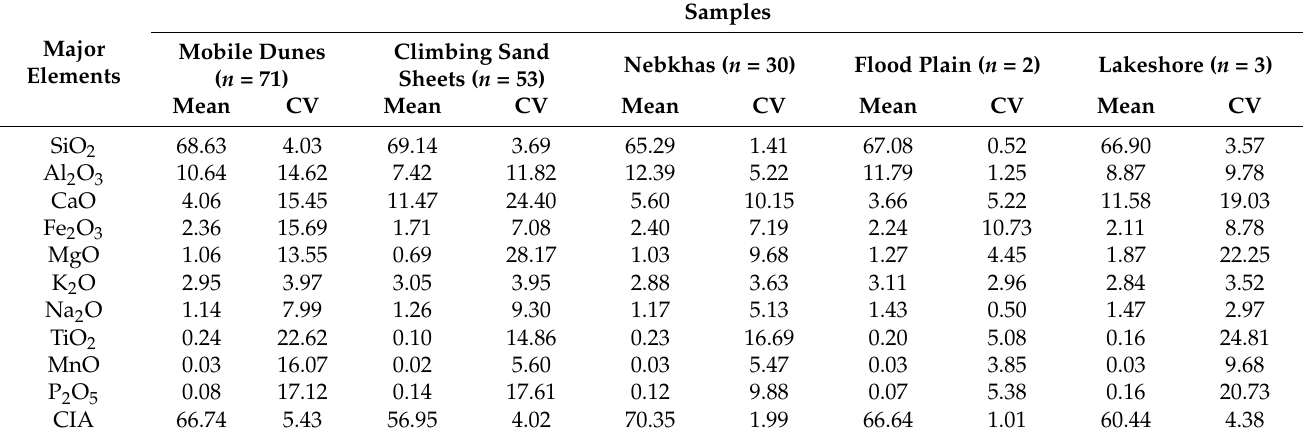
Table 1. Average content of major elements in aeolian sediments (%). n indicates the number of